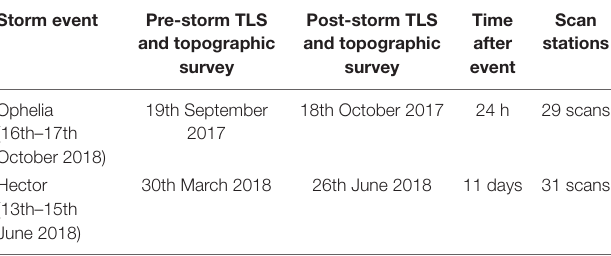
TABLE 1 | Main characteristics of the storm events studied and the topographic surveys performed to monitor geomorphological impact. Storm event